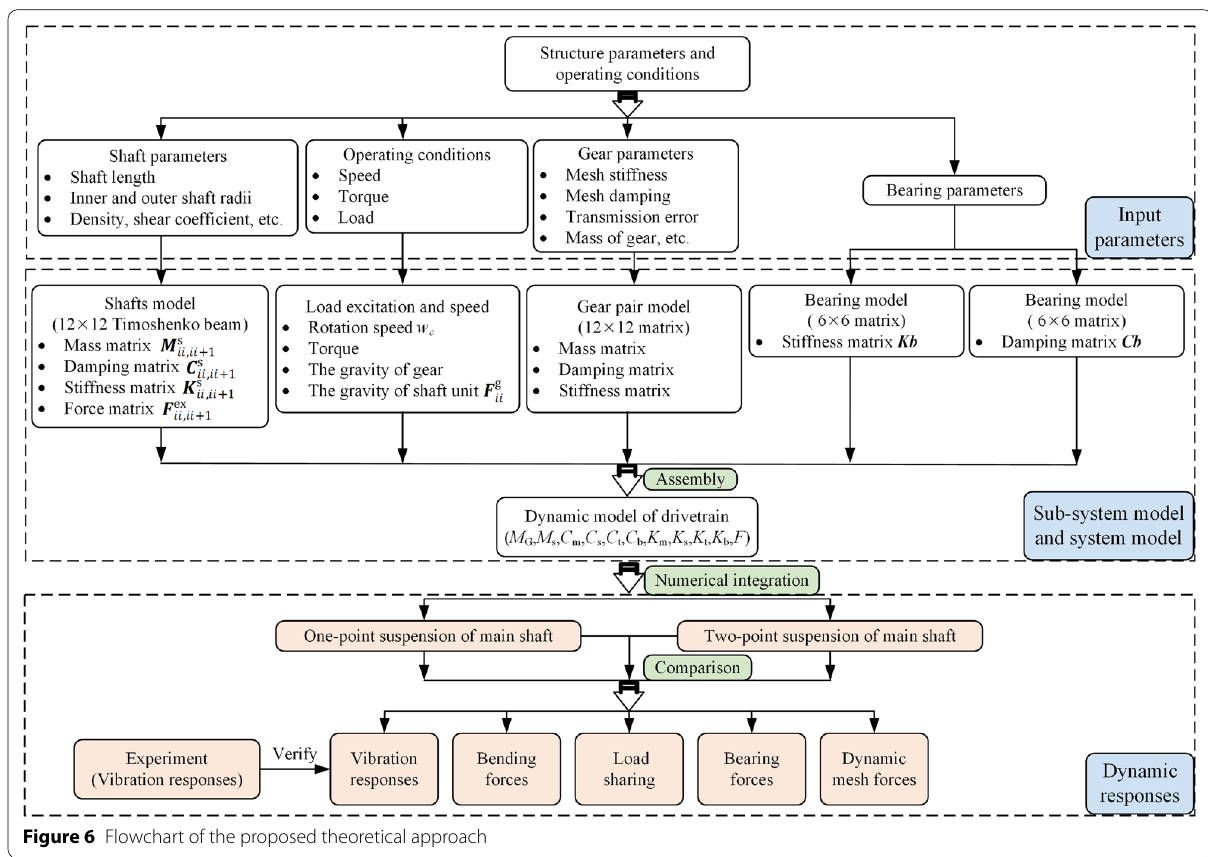
Figure 6 Flowchart of the proposed theoretical approach